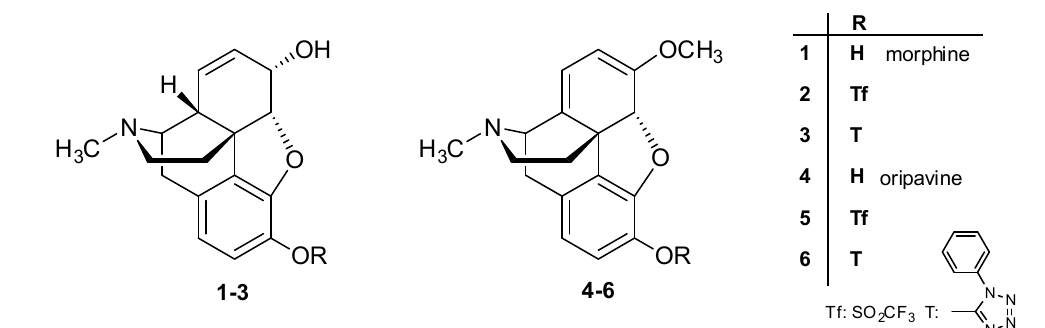
Figure 1. Structure of morphinans currently used for the synthesis of